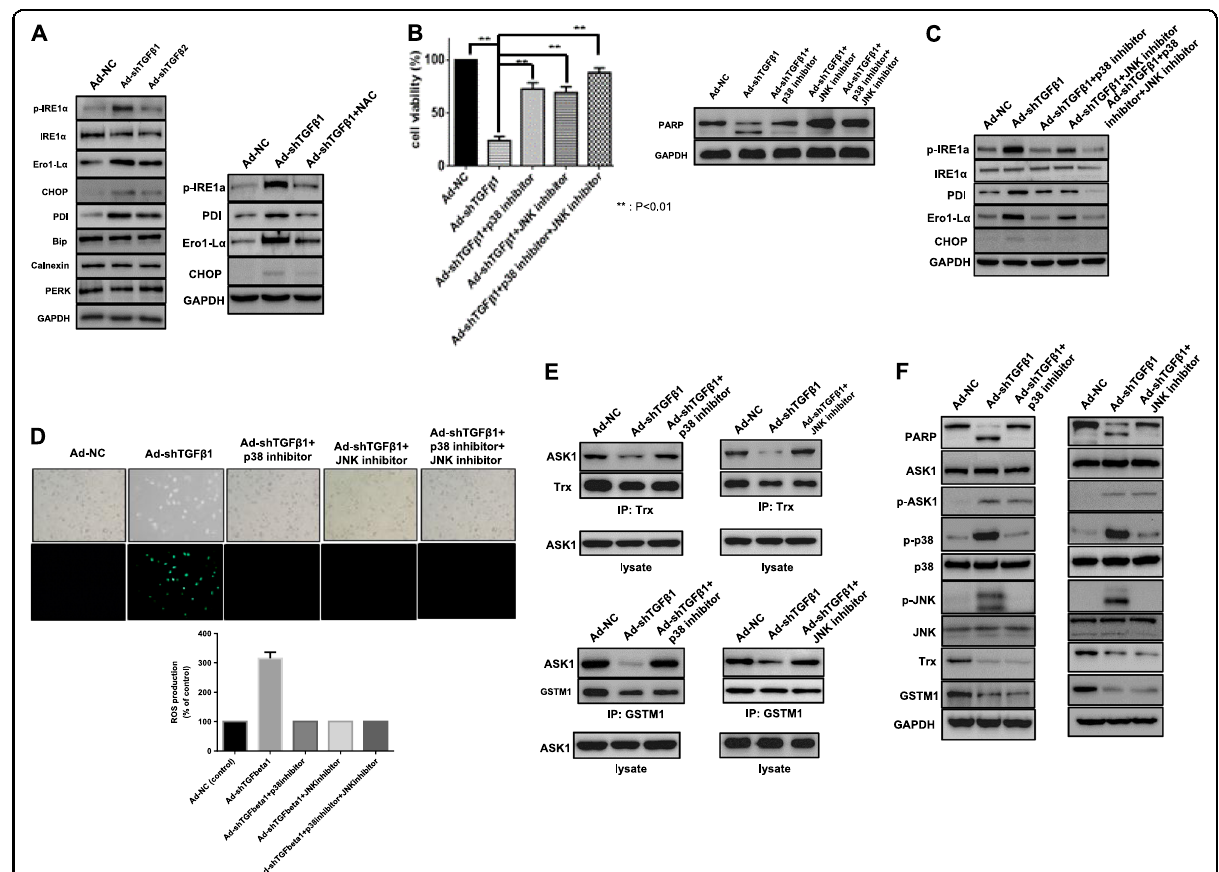
Fig. 6 Involvement of reciprocal ER stress and SAPK activation during TGF- β downregulation-induced cell death. a A375 cells were infected with adenovirus expressing shTGF- β 1 or - β 2. After 48 h, various ER stress-related proteins were detected by western blot analysis. b A375 cells were infected with adenovirus expressing shTGF- β 1 at 100 MOI, and after 6 h, infected cells were treated with a JNK inhibitor (SP600125, 10 μ M) or a p38 inhibitor (SB203580, 10 μ M) for 42 h. Then cell viability was tested using an MTS viability assay (left). Error bars represent the standard error from three independent experiments. Asterisks indicate a signi fi cant difference compared to each given control (** p < 0.01). Additionally, the expression levels of PARP and GAPDH were detected by western blot analysis (right). c A375 cells were infected with adenovirus expressing shTGF- β 1 at 100 MOI, and after 6 h, infected cells were treated with a JNK inhibitor (SP600125, 10 μ M) or a p38 inhibitor (SB203580, 10 μ M) for 42 h. Then ER stress-related proteins that responded to TGF- β downregulation (Fig. 5a) were detected by western blot analysis. d A375 cells were infected with adenovirus expressing shTGF- β 1 at 100 MOI, and after 6 h, infected cells were treated with a JNK inhibitor (SP600125, 10 μ M) or a p38 inhibitor (SB203580, 10 μ M) for 42 h and then incubated with DCF-DA (20 μ M, 1 h) for the detection of ROS using a fl uorescent reader and microscopy. e A375 cell lines were infected with adenovirus expressing shTGF- β 1 at 100 MOI, and after 6 h, infected cells were treated with a JNK inhibitor (SP600125, 10 μ M) or a p38 inhibitor (SB203580, 10 μ M) for 42 h. Then lysates were subjected to immunoprecipitation using an anti-Trx or anti-GSTM1 antibody to identify changes in ASK1. f A375 cells were infected with adenovirus expressing shTGF- β 1 at 100 MOI, and after 6 h, infected cells were treated with a